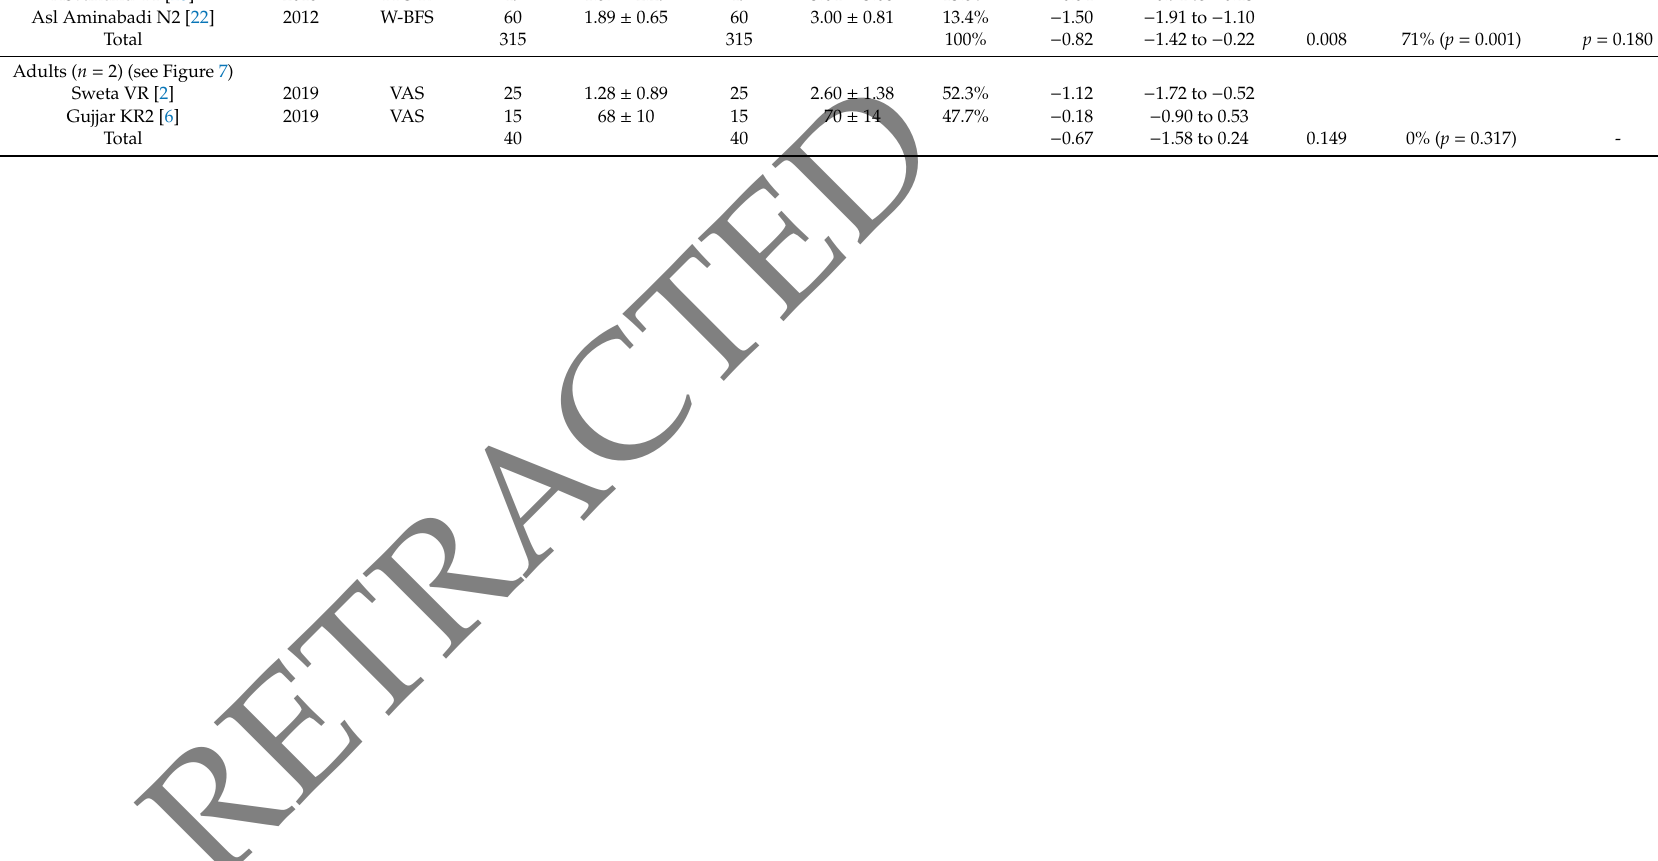
315 71% ( p = 0.001) p =